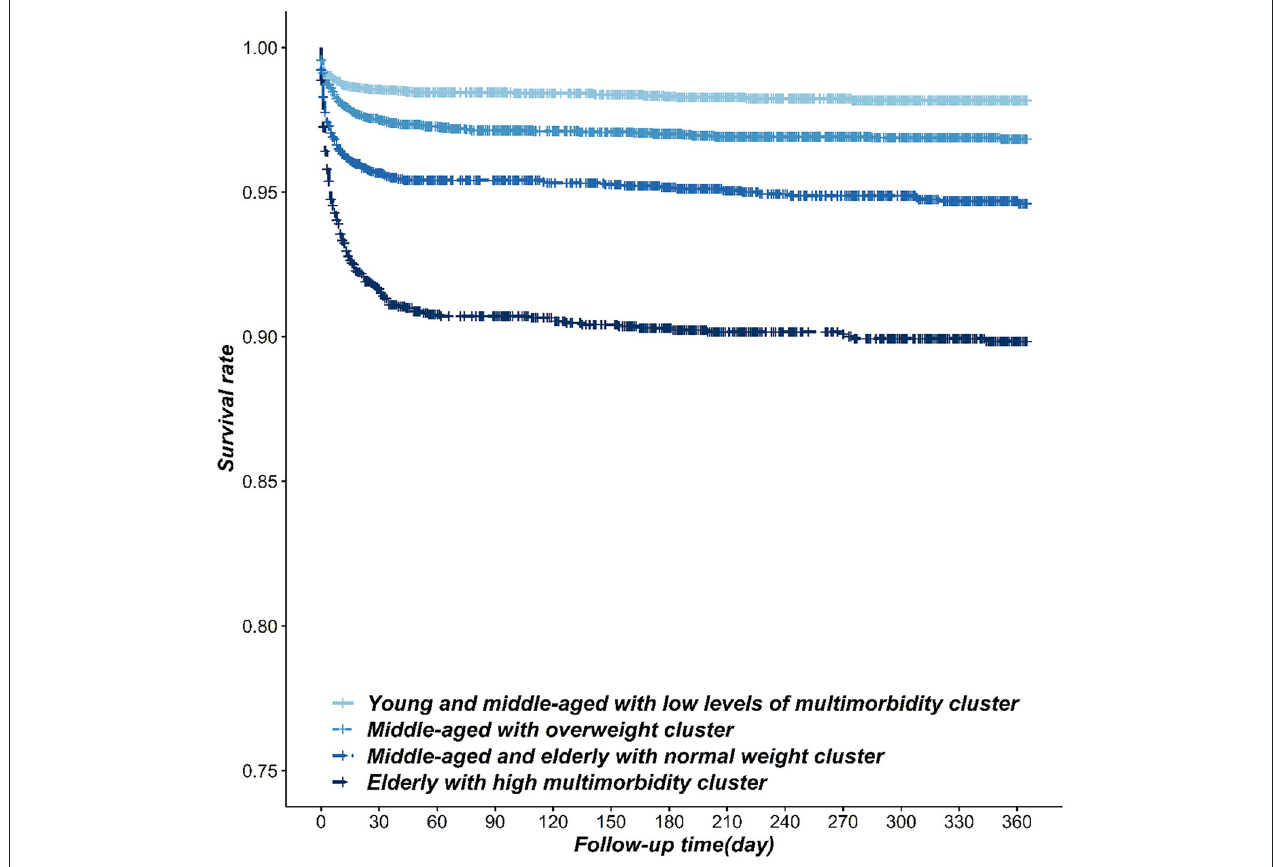
FIGURE 2 | The Kaplan-Meier survival curve of the incidence of all-death cause in STEMI patients within different risk factor